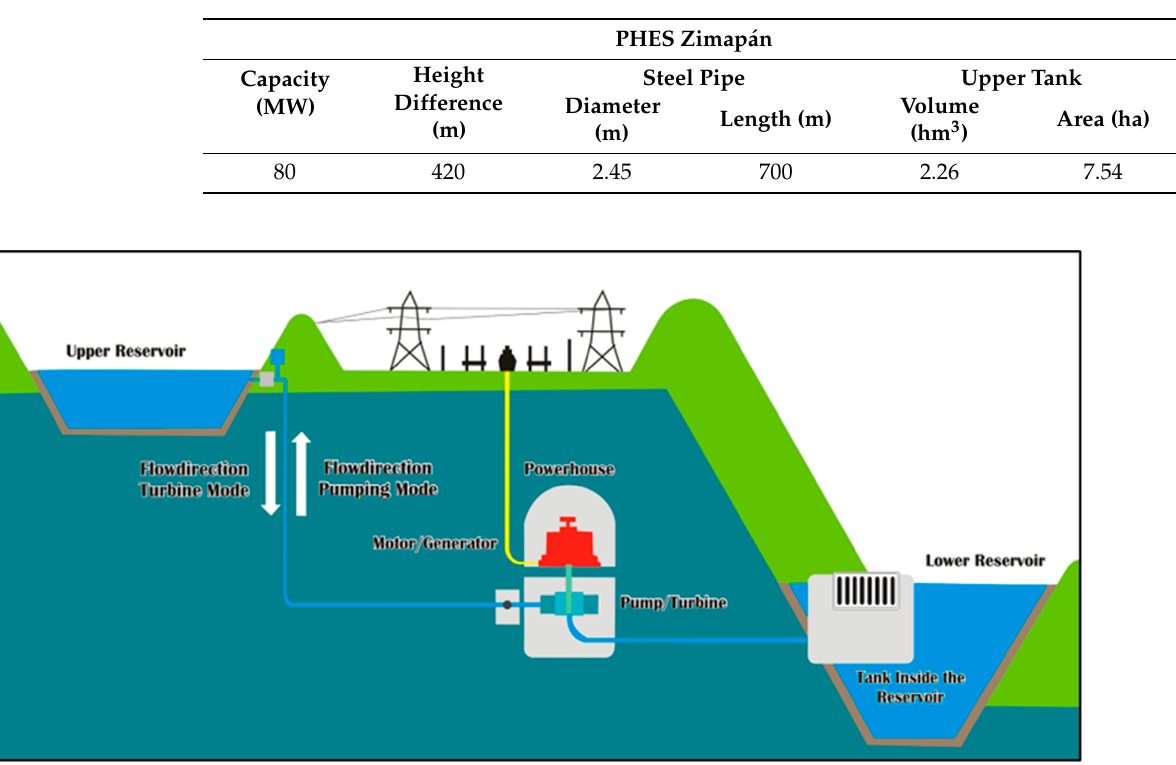
Figure 5. Siting scheme of the PHES Zimapán . Own source with IHA information.